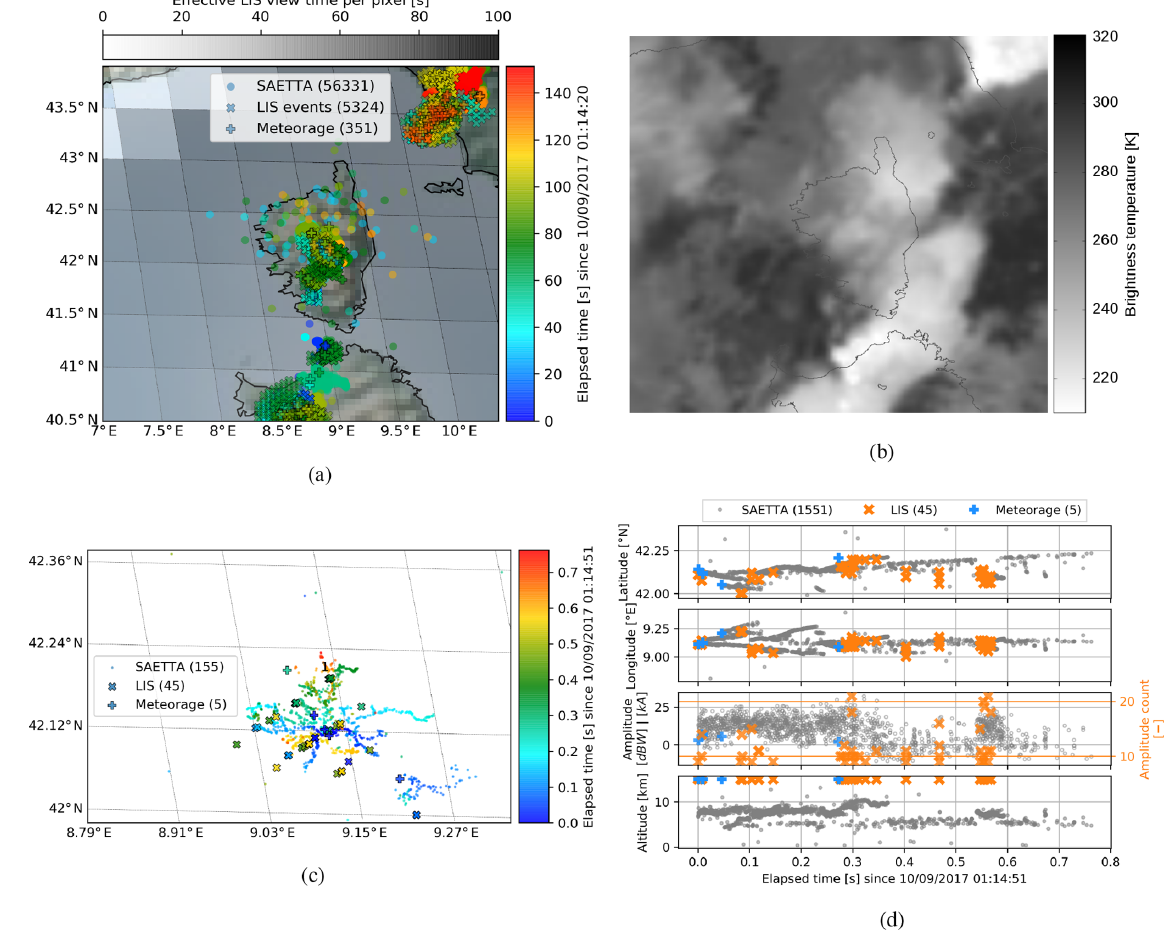
Figure 1. Observations of ISS-LIS events (as pixel centers), Meteorage pulses and strokes, and SAETTA VHF sources (as indicated) during one ISS overpass over Corsica on 10 September 2017 (a) . The ISS-LIS viewtime is presented as grayscale in the background. Numbers in parentheses give the number of SAETTA VHF sources, ISS-LIS events, and Meteorage pulses and strokes, respectively. Panel (b) shows the infrared (IR 10.8µm) satellite image of the same day at 01:15:00UTC (data visualization provided by the AERIS/ICARE Data and Services Center). One flash over Corsica detected by the three LLSs during the same ISS overpass is shown in (c) as a map and (d) as time series of latitude, longitude, signal strength amplitude (dBW for SAETTA, kA for Meteorage and amplitude count for ISS-LIS) and altitude (LIS and Meteorage set to